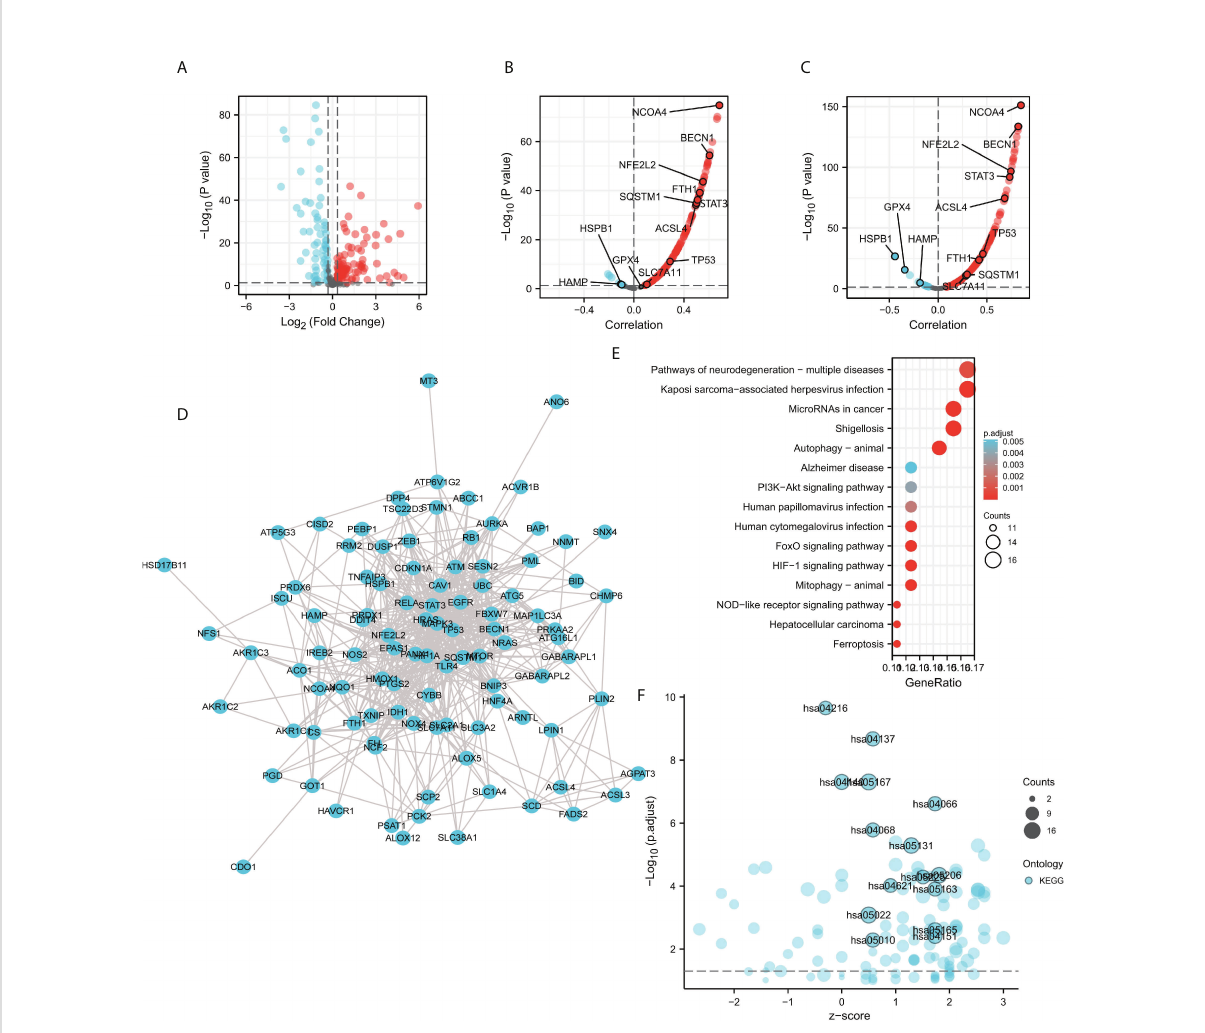
FIGURE 8 Correlation analysis of ACO1, REB2 expression with ferroptosis-related genes in TCGA-KIRC database. (A) Volcano plots showing the 150 differentially expressed ferroptosis-related genes in the TCGA-KIRC database compared with normal controls. (B, C) Volcano plots show the correlations between ACO1 (B) , IREB2 (C) , and the 150 ferroptosis-related genes in KIRC. (D) The PPI network of the 150 genes was generated using STRING. (E) A bubble chart shows top 15 KEGG enrichment pathways for the 150 genes in KIRC. (F) A bubble chart shows top 15 KEGG enrichment pathways with z-score for the 150